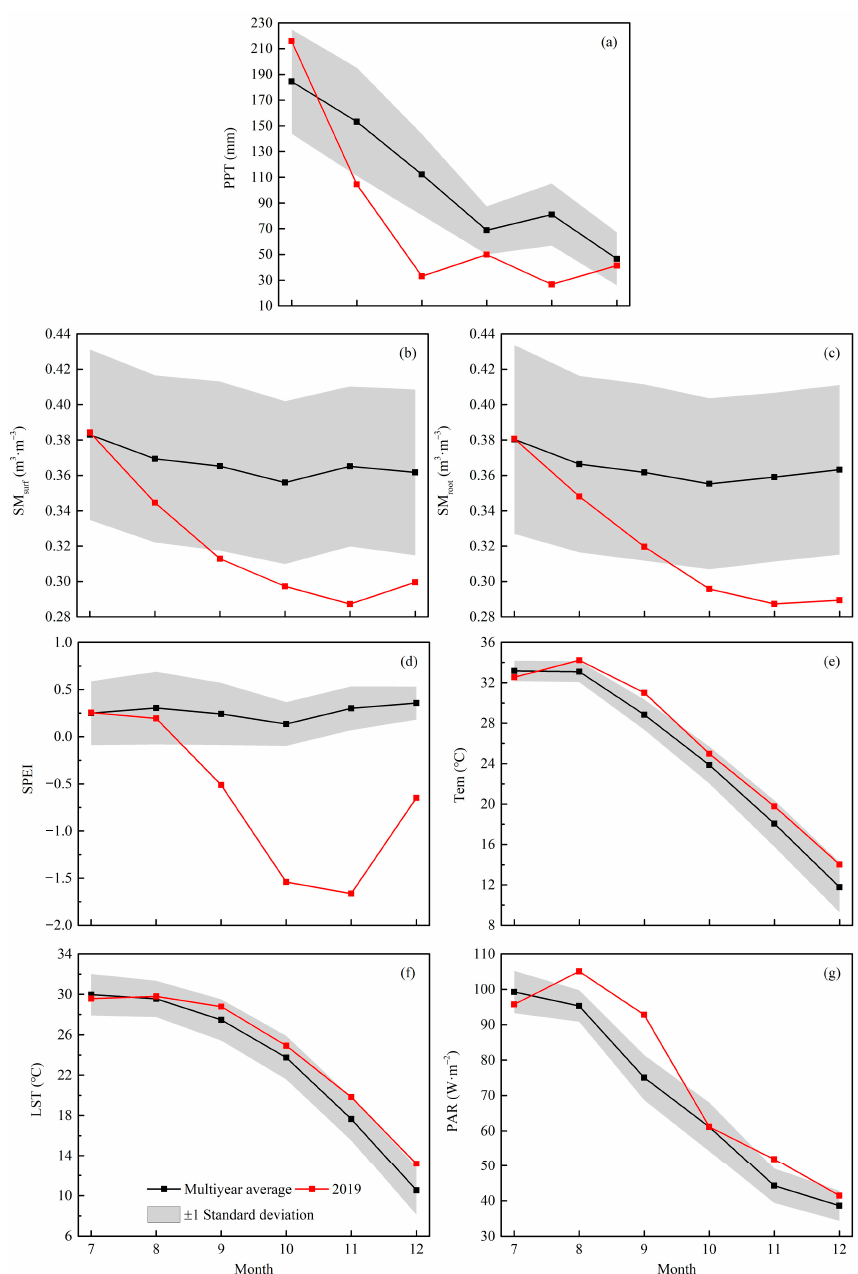
Figure 7. Variations of ( a ) PPT, ( b ) SM surf , ( c ) SM root , ( d ) SPEI, ( e ) Tem, ( f ) LST, and ( g ) PAR from July to December 2019. Note: The black curves denote the multi-year monthly averages of these variables during 2011–2020; the red curves denote the monthly average of these variables in 2019; the grey shaded areas denote the ±1 standard deviation of the multi-year monthly averages.